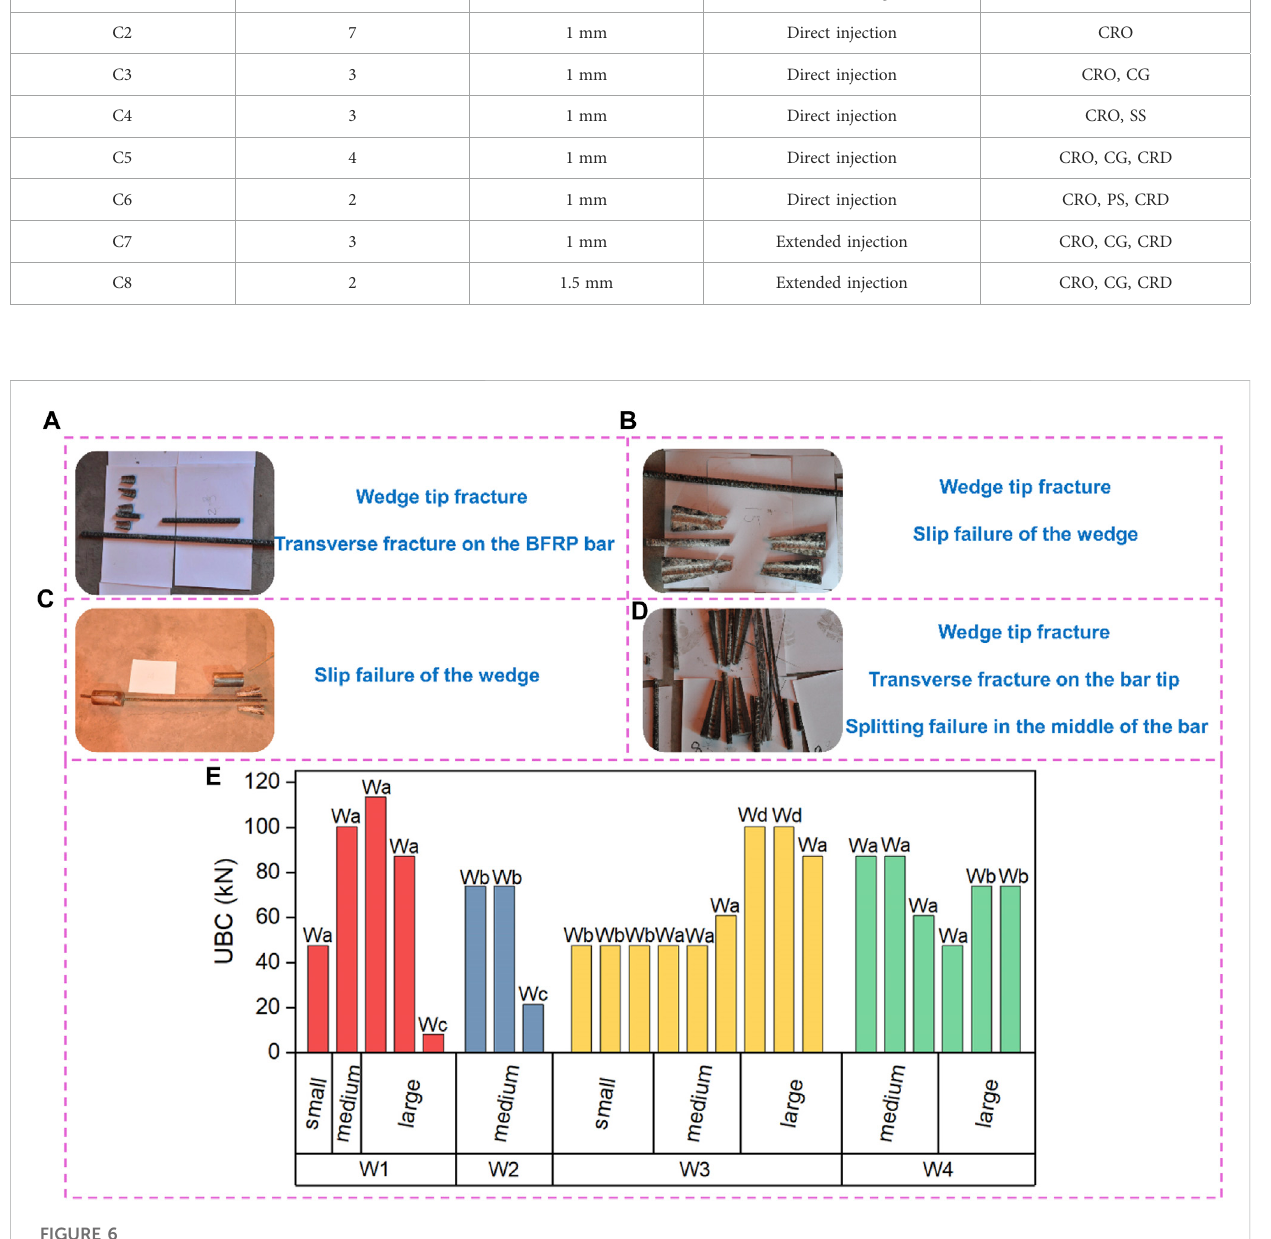
FIGURE 6 FailuremodesandUBCtestresultsoftheWMASs: (A) FailuremodeWa, (B) FailuremodeWb, (C) FailuremodeWc, (D) FailuremodeWd, (E) UBCtest results of